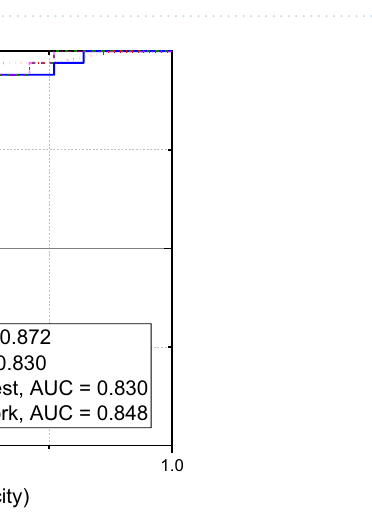
Figure 4. Difference in response of the MiCS-6814 (NO 2 ) gas sensor between the groups of COVID-19- infected patients (33), healthy volunteers (17) and ambient air (6) for three selected parameters of major difference: ( a ) F1, ( b ) F2, and ( c ) F3. IQR –interquartile range, presenting the statistical dispersion of the considered data.